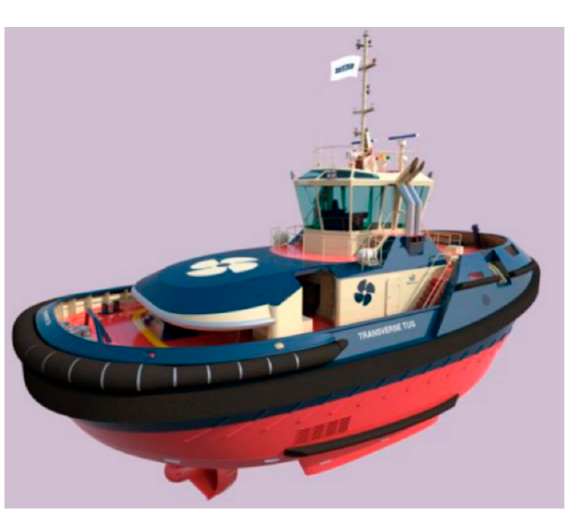
Figure 39. The new type of tugboat proposed by the A.P. Moller Maersk Group [174].